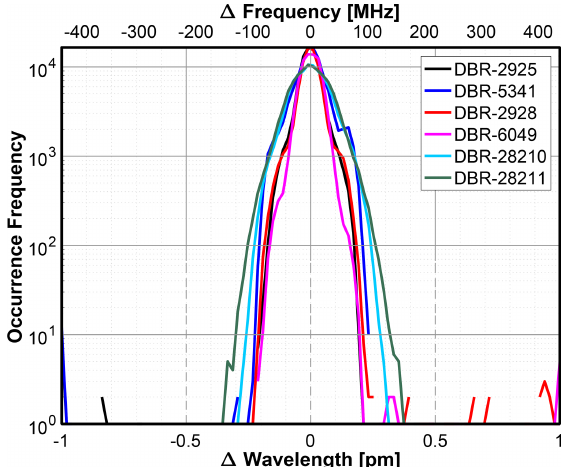
Figure 6. Wavelength stability of six different fiber-coupled DBR lasers over a period of 10d (1 January 2020 at 00:00UTC to 9 Jan- uary 2020 at 24:00UTC). The time period was chosen to repre- sent steady-state operation and contained no user-defined system changes. Data are measured with a wavelength meter from a 10% tap of the fiber-coupled seed